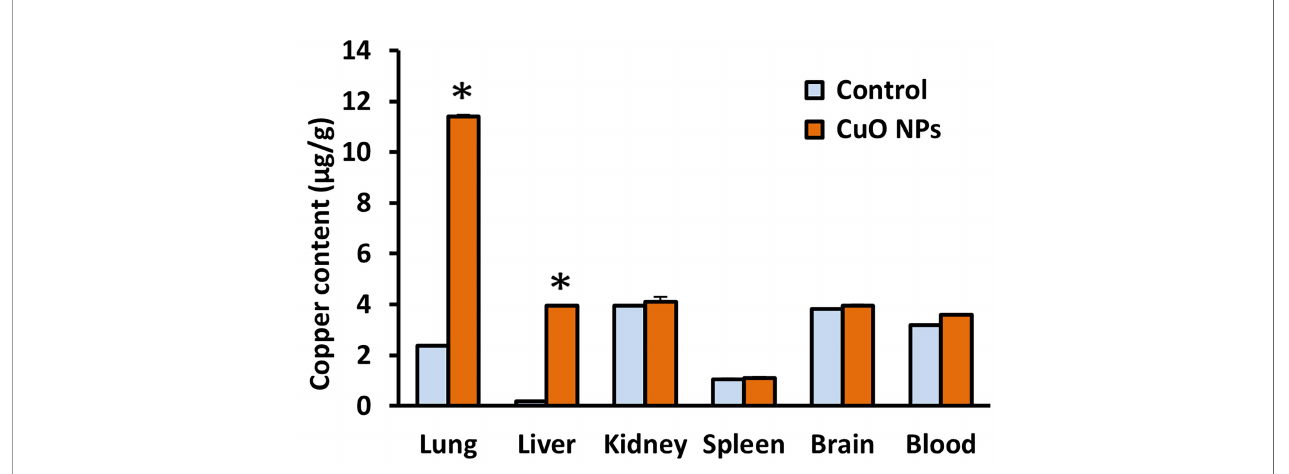
FIGURE 3 | Mean content of copper in mouse organs and blood after 6-week inhalation of CuO NPs. Blood and organs were derived from mice exposed to NPs (n = 5) and controls (n = 5). Control – control group, CuO NPs – group exposed to CuO NPs. Bars indicate mean group values (mean + SD). Signi fi cance: *p <